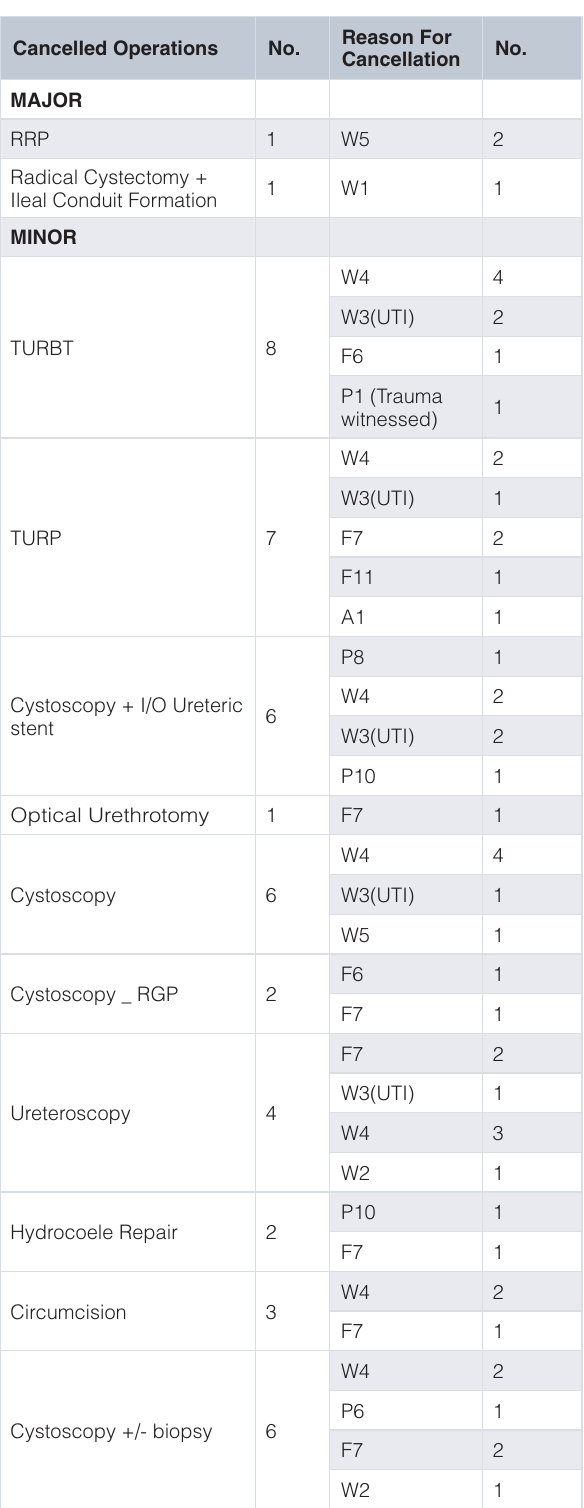
Table 6. Breakdown of cases cancelled on the day of surgery and the reasons for their cancellation. Cancellation reasons are classified as per Argo et al’s cancellation